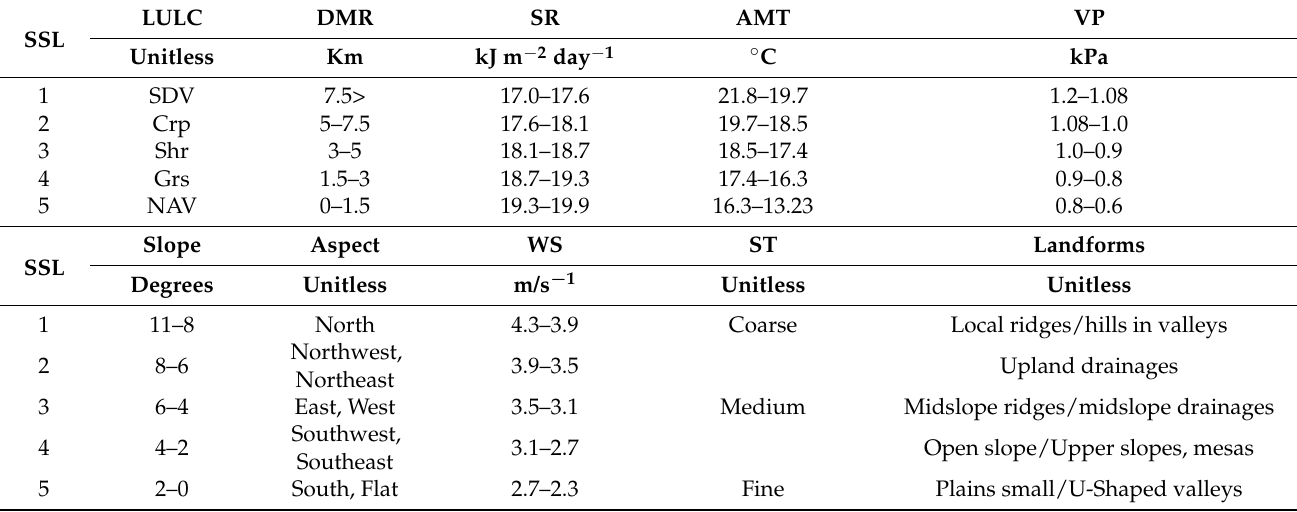
LULC = Land use/land cover, DMR = Distance to main roads, SR = Solar radiation, AMT = Annual mean temperature, VP = Vapor pressure, WS = Wind speed, SSL = Site suitability level, SDV = Sandy desert vegetation, Crp = Cropland, Shr = Shrubland, Grs = Grassland, NAV = No apparent vegetation, ST = Soil